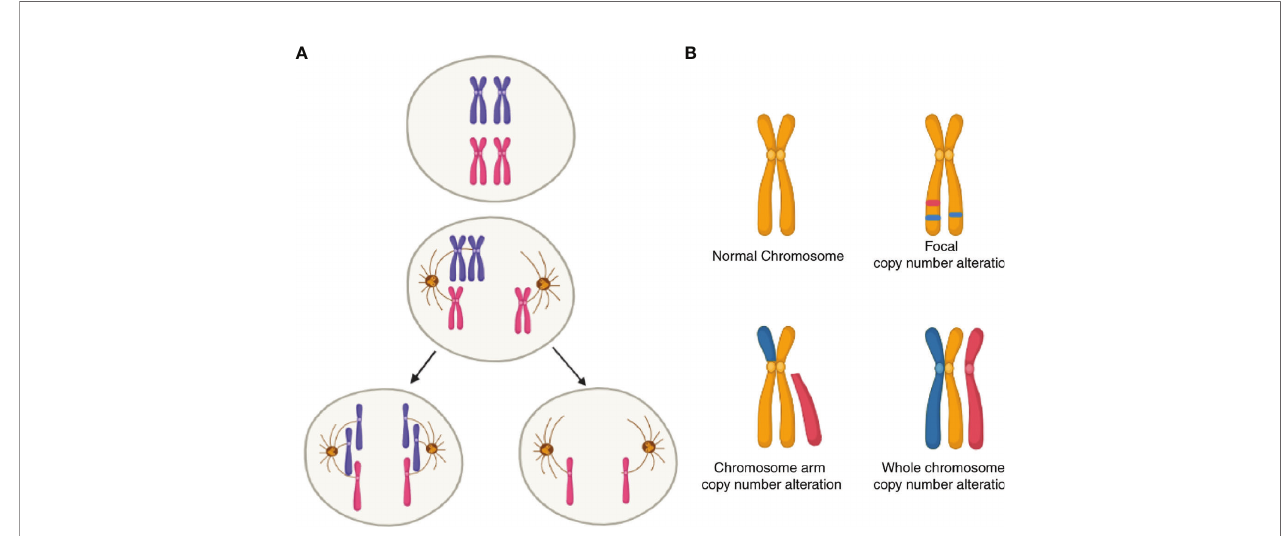
FIGURE 2 | Schematic of somatic copy-number alterations (SCNA). (A) Mis-segregation during cell division leads to the production of aneuploidy cells. (B) Three broad categories of SCNA, with red color showing regions of copy-number gain and blue color showing regions of copy-number loss. The top-left panel represents a healthy (diploid) chromosome. The top-right panel is a chromosome with focal level SCNA events. The bottom-left panel represents chromosome-arm level SCNA events. The bottom right panel is whole-chromosome level SCNA